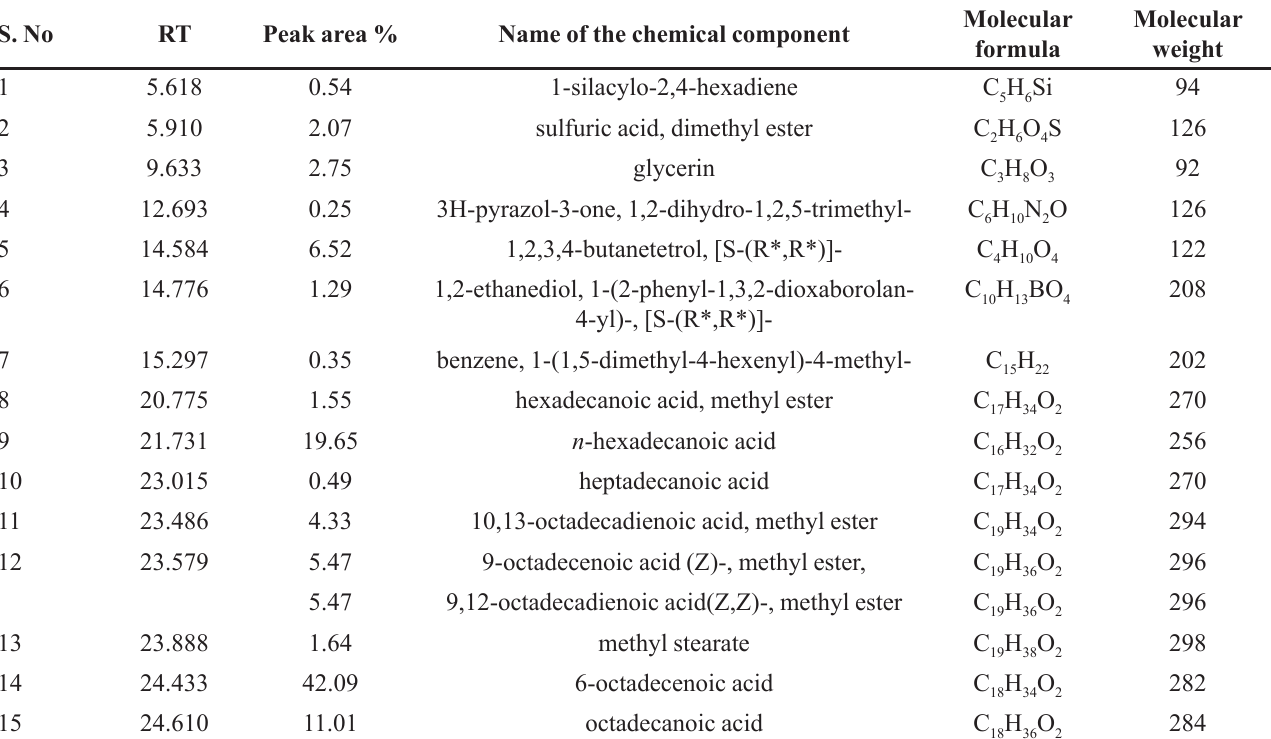
TABLE III - Phytocomponents identified by GC-MS analysis S. No RT Peak area % Name of the chemical